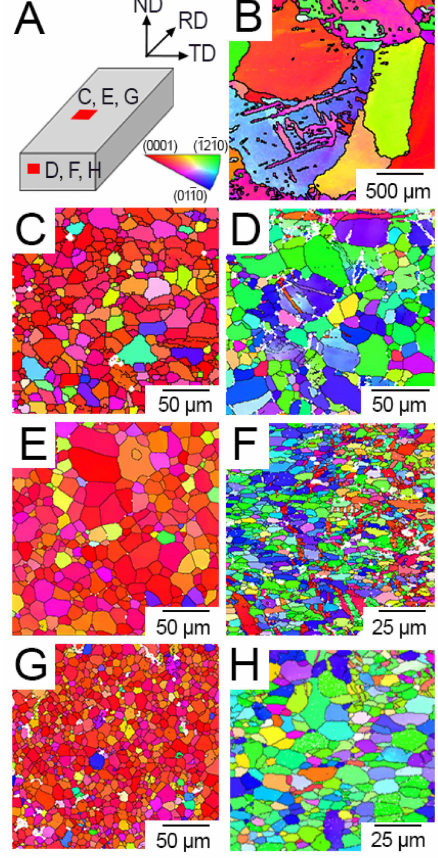
Figure 1. Representative inverse pole figure (IPF) maps of AC and rolled samples reflecting the relationship between the crystal plane normals and the surface normal: ( A ) Schematic of map locations with respect to the RD, ( B ) AC, ( C ) R30 parallel to the RD, ( D ) R30 normal to the RD, ( E ) R40 parallel to the RD, ( F ) R40 normal to the RD, ( G ) R50 parallel to the RD, ( H ) R50 normal to the RD.